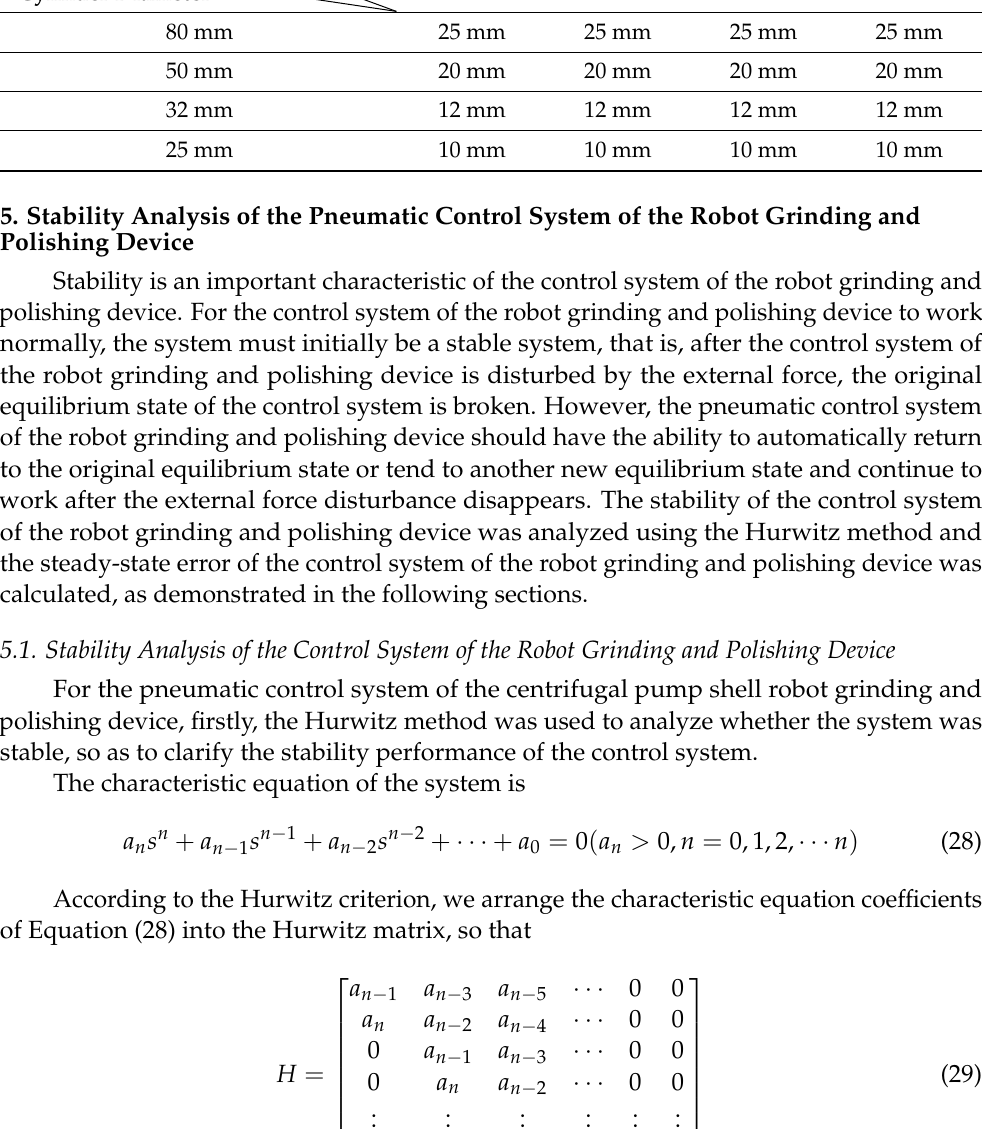
Table 2. Structural parameters of the different cylinders.